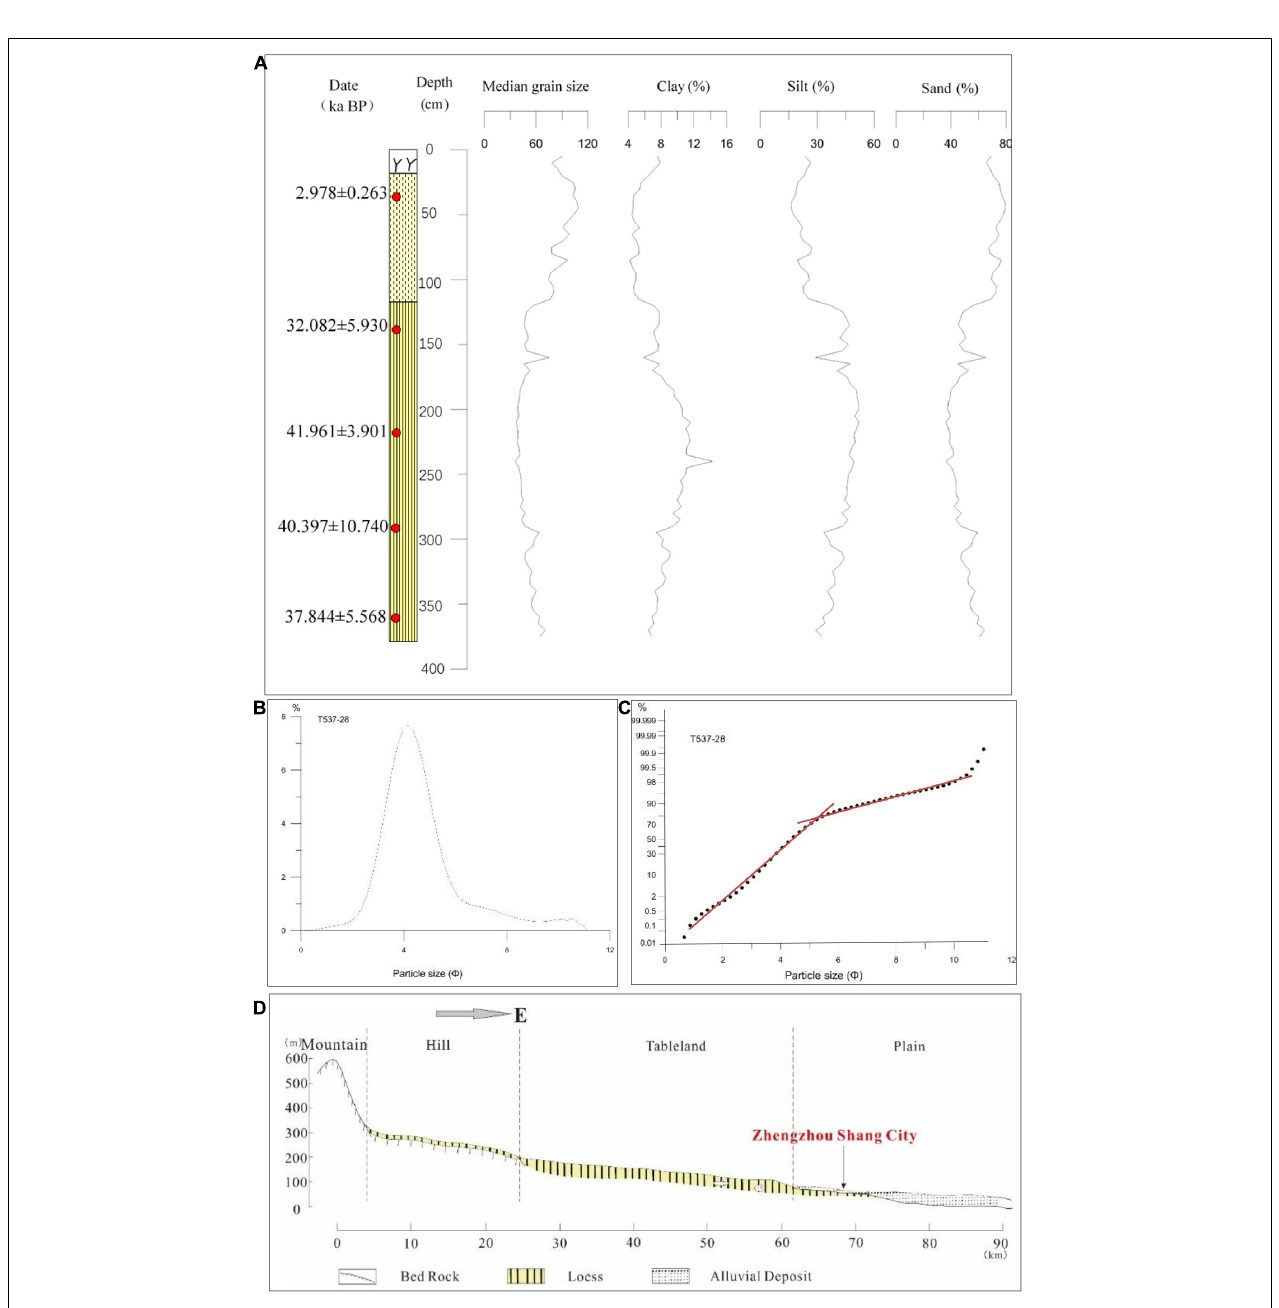
FIGURE 2 | Particle size analysis (A) The particle size component of T537 profile in No.34 courtyard. The OSL ages are marked on the stratigraphic section according to the depth. Although the three ages are inverted in the bottom, all of them fall into the Late Pleistocene, and their errors are also within the appropriate range. (B) The frequency distribution curve of sample 28 (140 cm) of T537. (C) The probability cumulative curve of sample 28 of T537. (D) The geomorphic position of Zhengzhou Shang